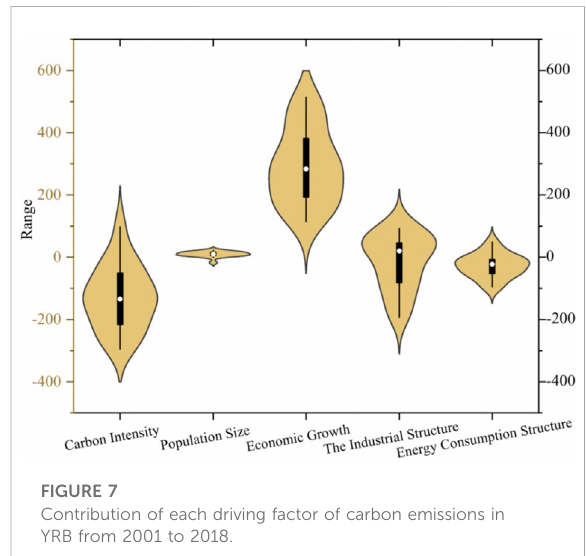
FIGURE 7 Contribution of each driving factor of carbon emissions in YRB from 2001 to